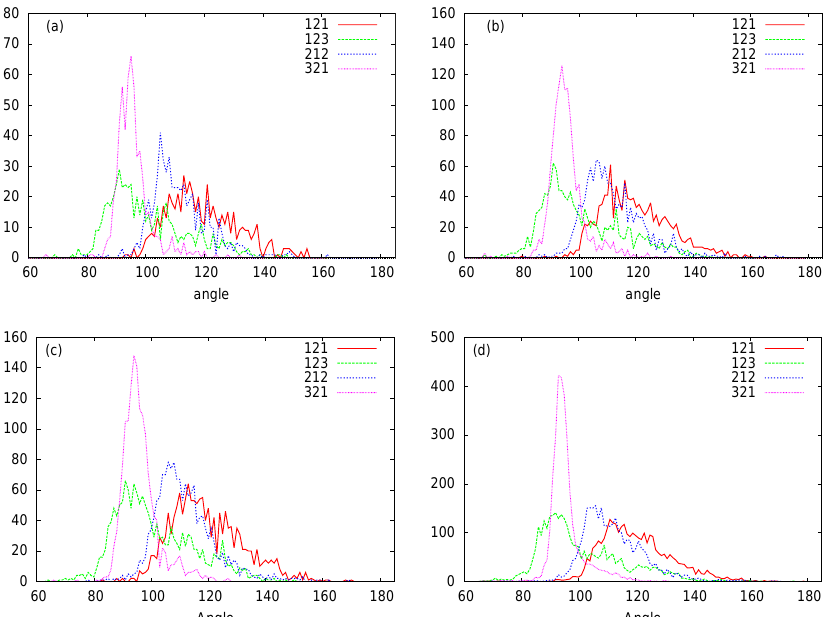
Figure 6. PSP, SPS bond angle histograms for the ( a ) two-ring nanotube ( b ) four-ring nanotube ( c ) five-ring nanotube ( d ) 10-ring nanotubes. (Here in the figure 1-Phosphate (P), 2-Sugar Ring (S), and 3-Nucleobase (N).)